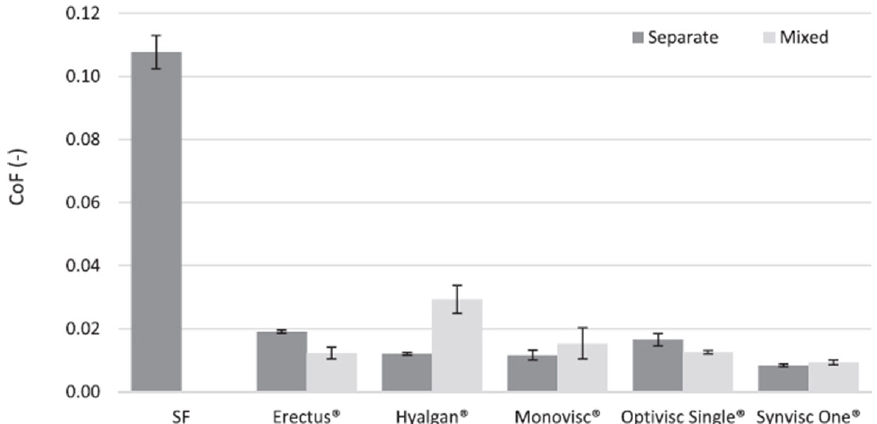
Fig. 22 COF at the end of measurements for all tested lubricants [243]. Reproduced with permission from Ref. [243], © Elsevier Ltd.,